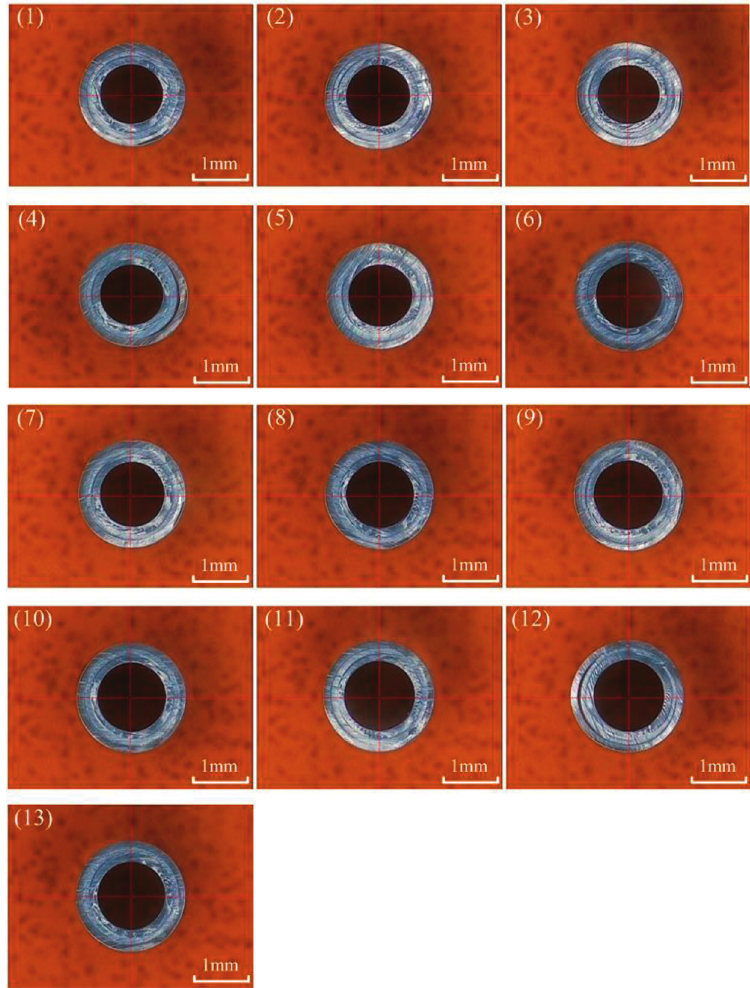
� 4 mL/min, (b) Q � 6mL/min, (c) Q � 8mL/ 1 2 3